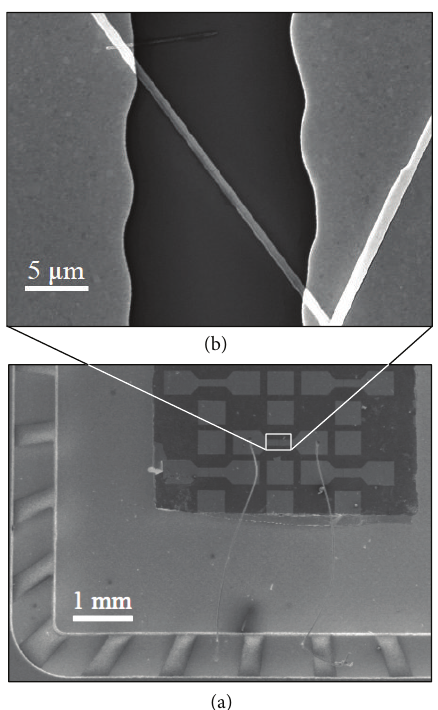
Figure 1: Scanning electron microscopy (SEM) image (a) shows the electrical connection via gold wire bonding between the device electrodes and the chip carrier; in (b) a close up of the single ZnO nanowire bridging the two electrodes is presented.